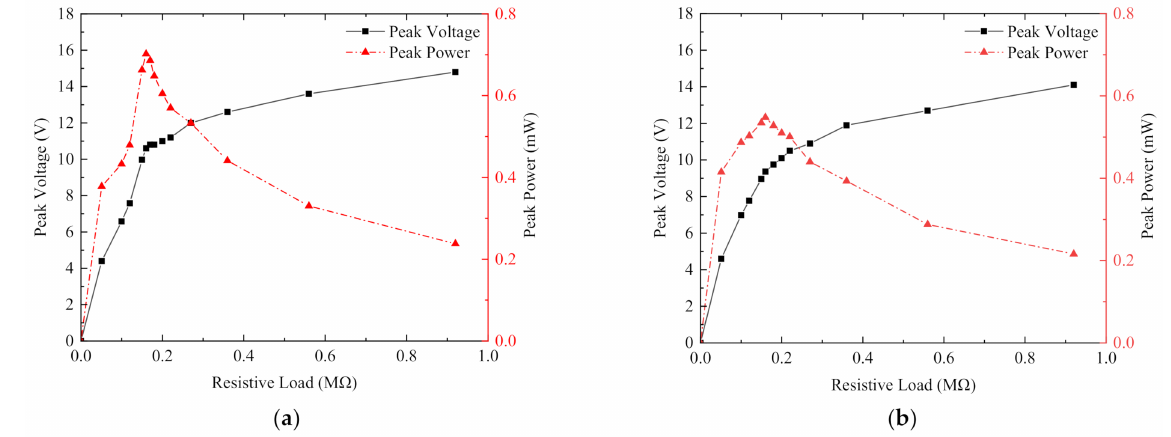
Figure 13. Output voltage and power of the magnetically coupled piezoelectric harvester: ( a ) load voltage and output power obtained from the rectifying circuit of x-x piezoelectric sheets; ( b ) load voltage and output power obtained from the rectifying circuit of y-y piezoelectric sheets.